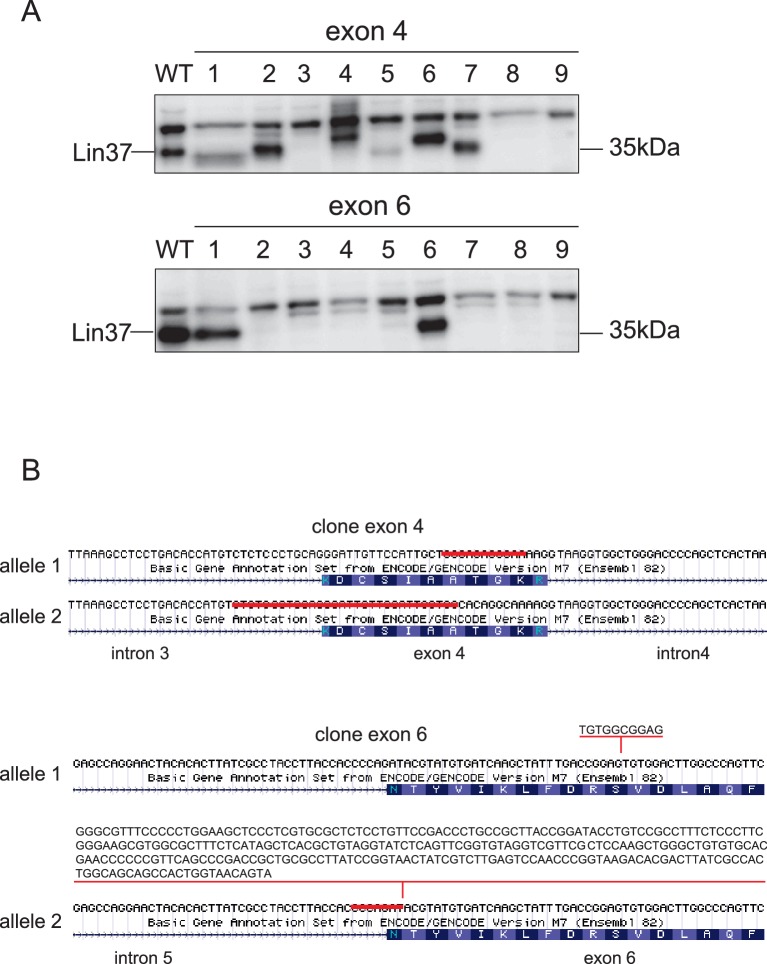
Lin37 knockout clones can be established by CRISPR/Cas9 nickase with a high efficiency.RIPA lysates of Lin37 wild-type NIH3T3 and single cell clones treated with plasmids expressing sgRNA targeting the 5’ end of Lin37 exon 4 or 6 were probed with a Lin37 antibody (A). Nine representative clones are shown for each approach. (B) Genotyping of two clones showing deletions (clone exon 4) or insertion and deletions (clone exon6) in the Lin37 gene introduced by CRISPR/Cas9 nickase.